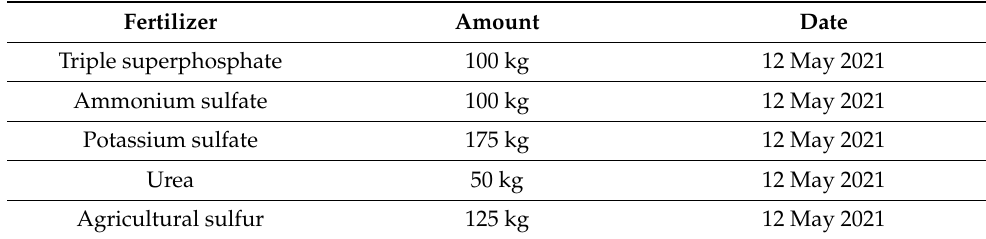
Table 3. Amounts of fertilizer